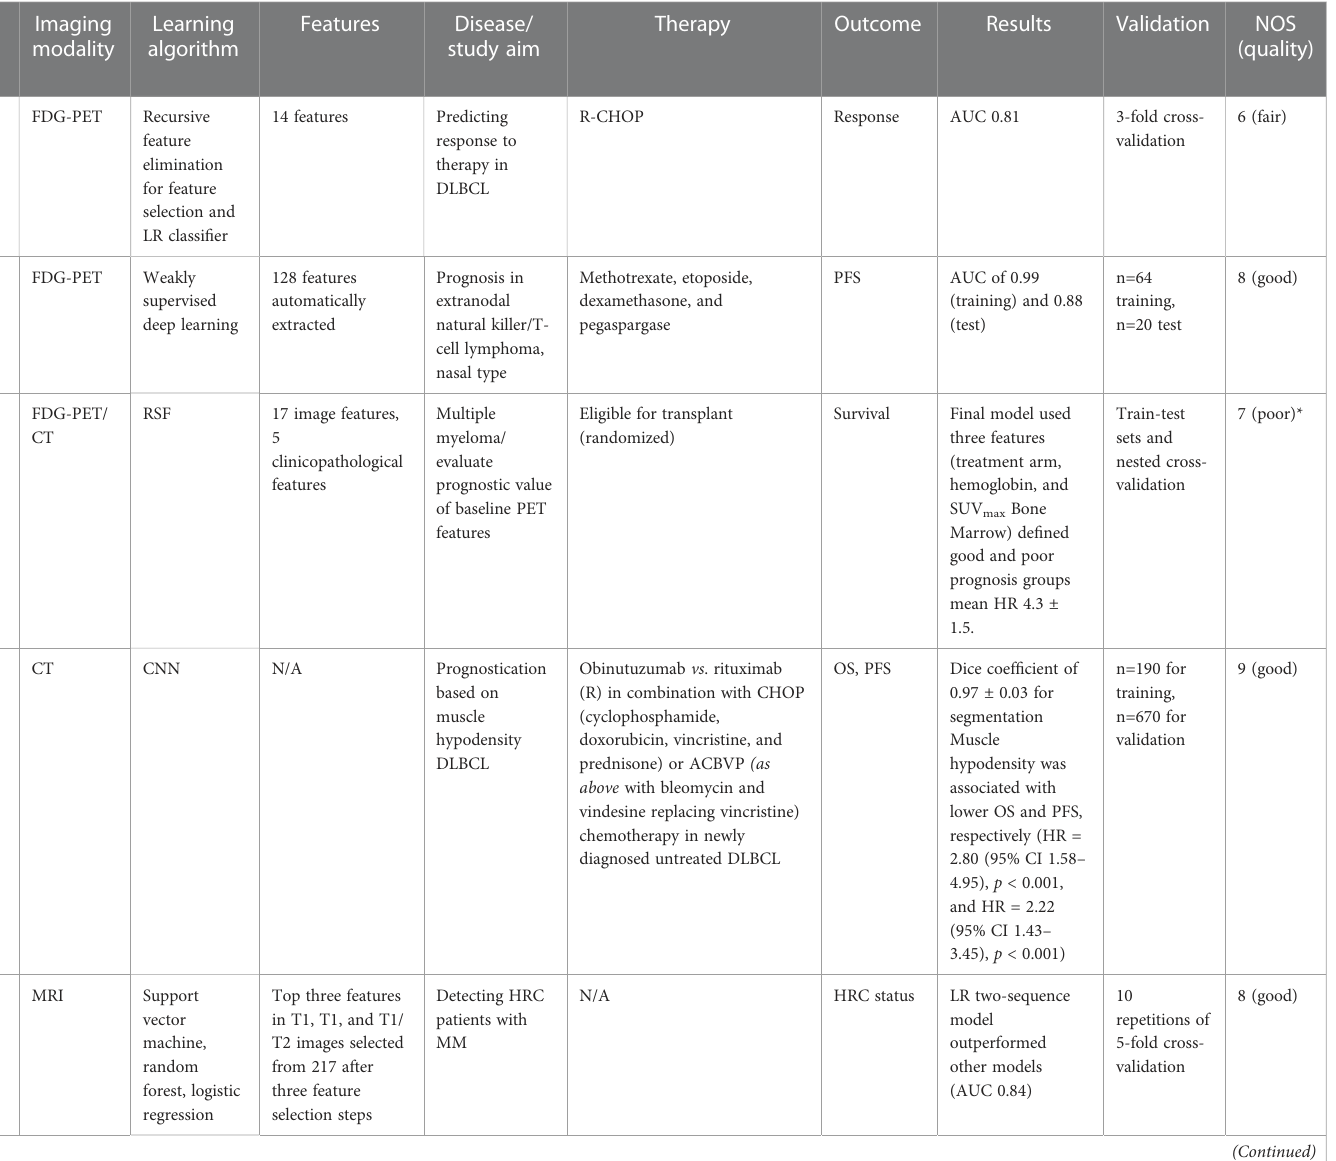
TABLE 3 Studies applying machine learning for the prognosis/prediction of responses to